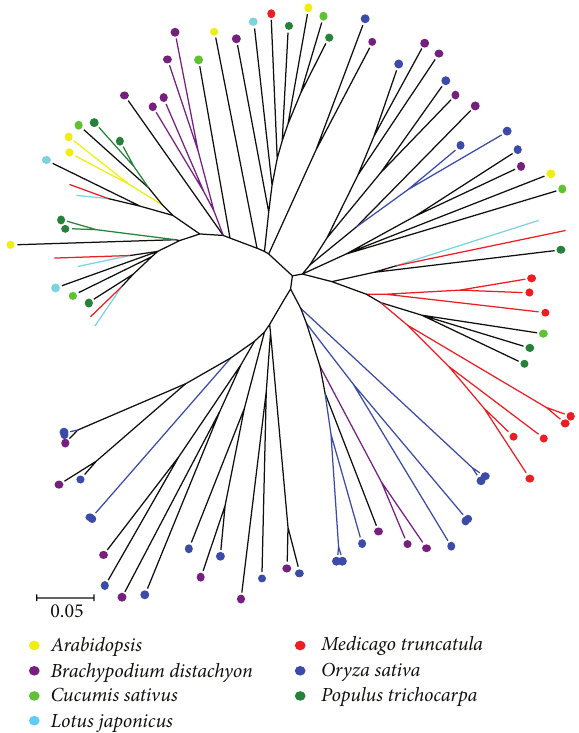
Figure 6: Phylogenetic tree of group III WRKY domains from Ara- bidopsis , Brachypodium distachyon , Cucumis sativus , Lotus japon- icus , Medicago truncatula , Oryza sativa , and Populus trichocarpa . The phylogenetic tree was constructed using MEGA 4.0 by the Neighbor-Joining (NJ) method with 1,000 bootstrap replicates. Each WRKY predicted orthologous gene was indicated in a specific